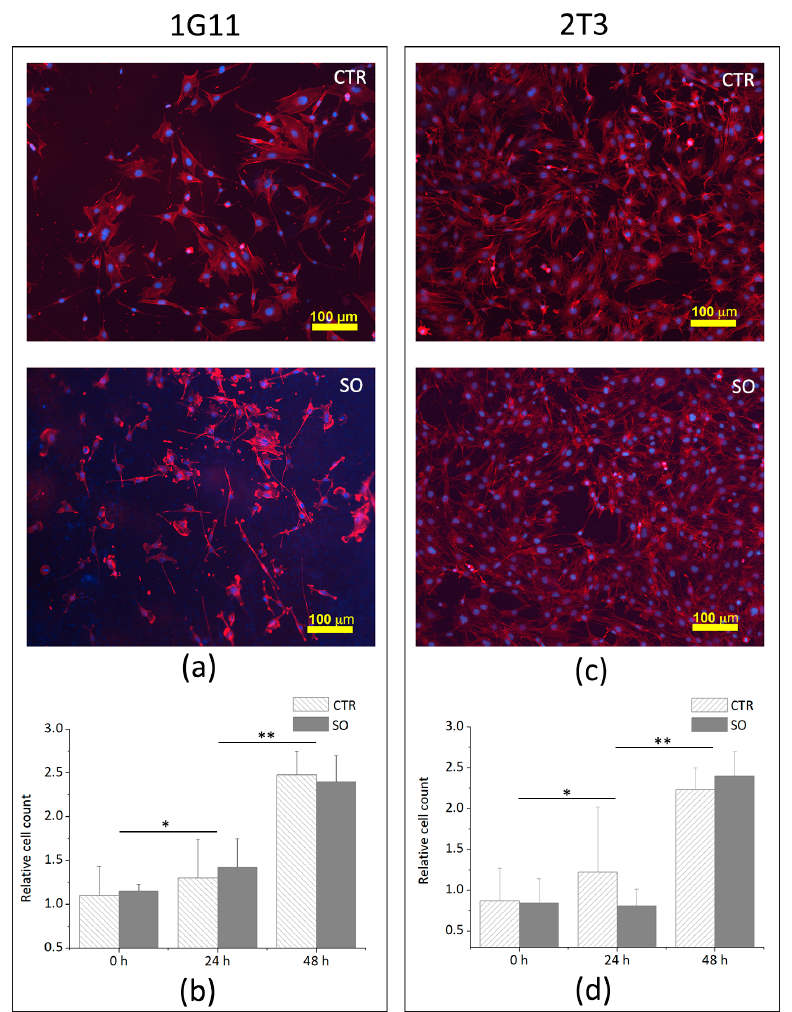
Figure 4. 1G11 and 2T3 cultured on plastic plate (CTR) or on scleral ossicle surface (SO); ( a ) morphology of 1G11 cultured for 24 h; ( b ) negative trypan blue 1G11 counted after 24 and 48 h of ( c ) morphology of 2T3 cultured for 24 h; and ( d ) negative trypan blue 1G11 counted after 24